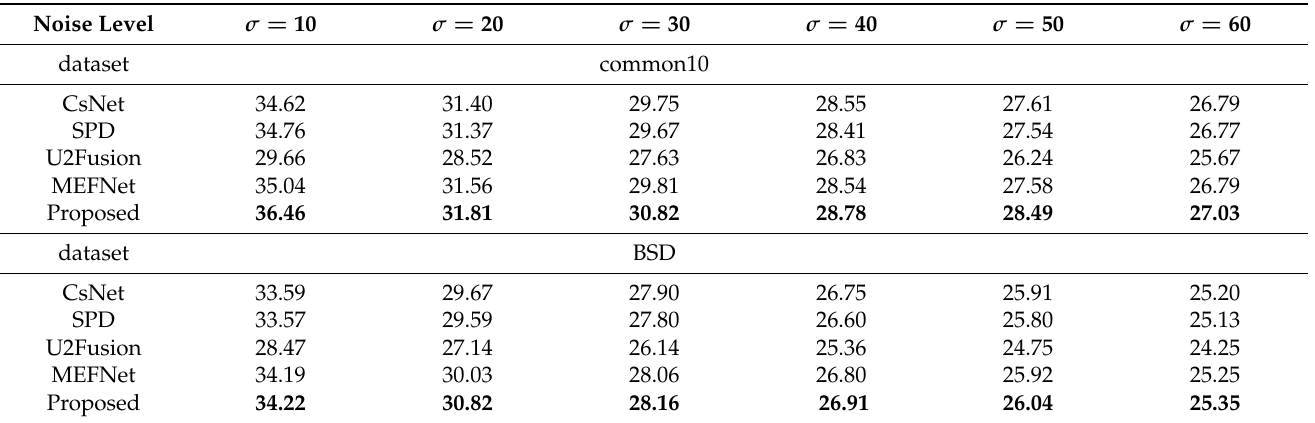
Table 4. Average performance of various combination strategies for different noise